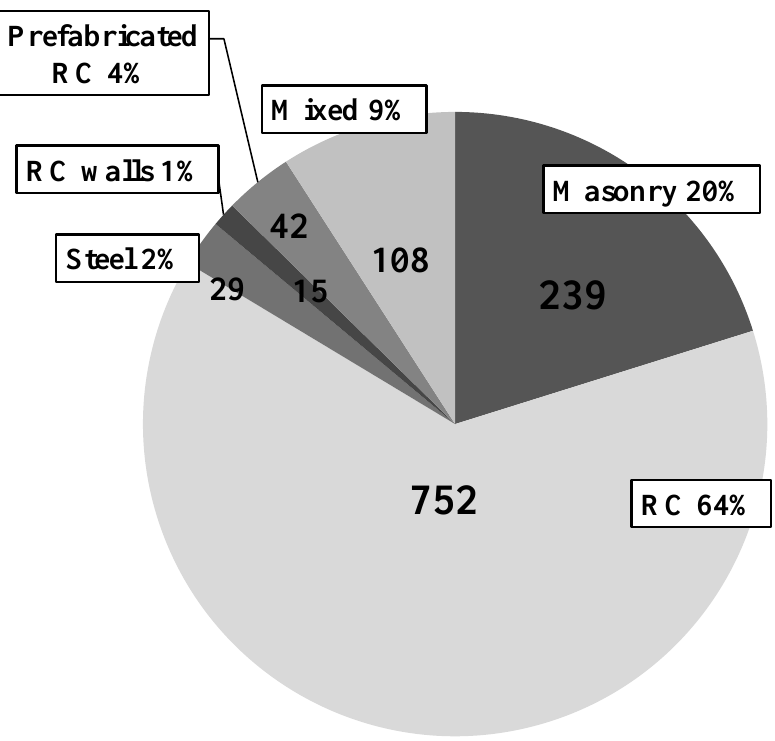
Figure 3. Occurrence of different vertical structural systems within the initial dataset of 1185 buildings.